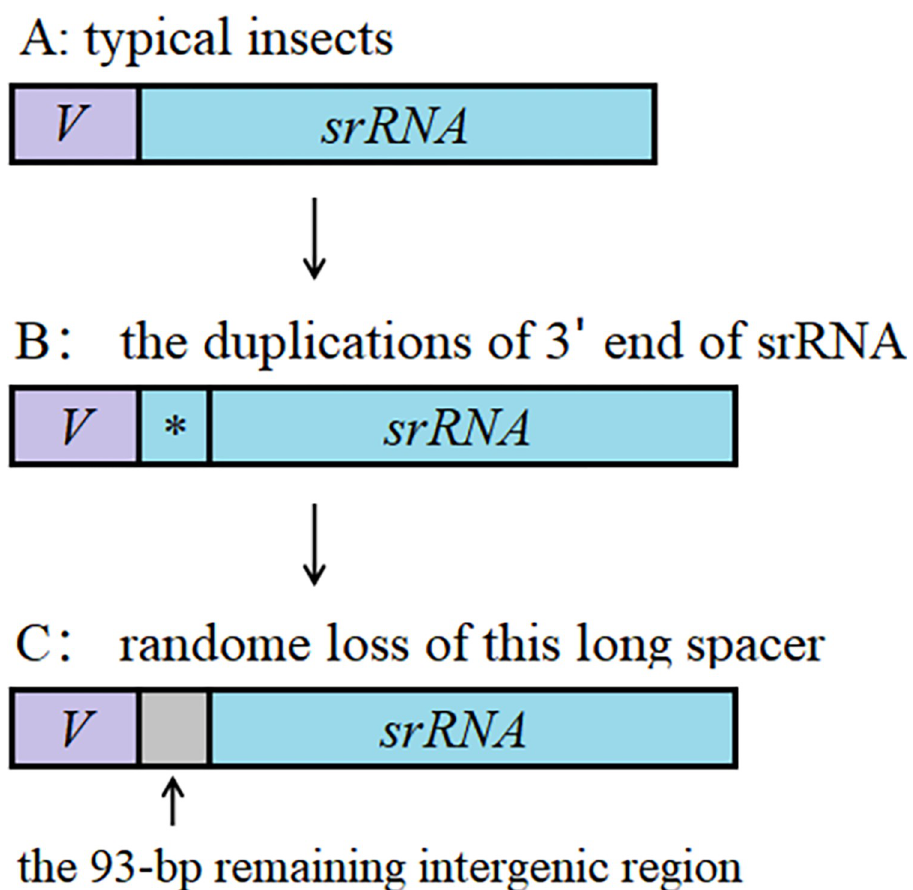
Fig 5. Putative formation mechanism of the intergenic spacer in Episymploce splendens mito-genome. The Randomly copied fragment was marked with � .